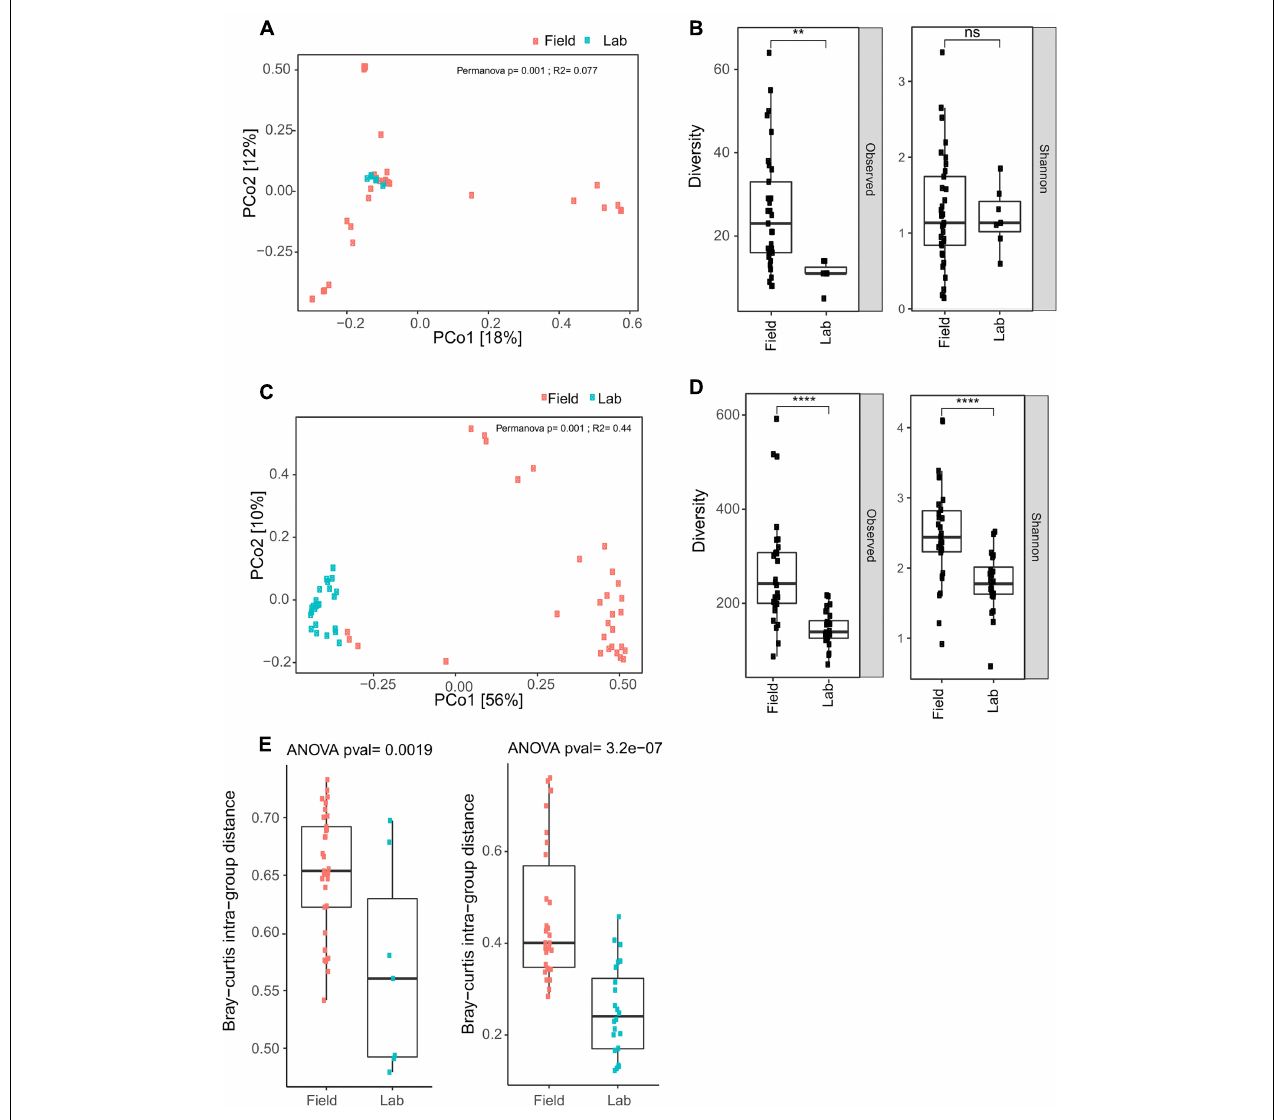
FIGURE 8 | Field collected samples display greater eukaryotic and prokaryotic microbial diversity than laboratory colony samples. (A) Bray Curtis Principal Coordinate Analysis (PCoA) for eukaryotic OTU data reveal clustering of field and laboratory colony samples. The cluster of eukaryotic microbes in the colony samples is nested within the distribution of data points for the field samples. (B) Observed diversity of eukaryotic taxa is significantly greater in field collected samples as compared to laboratory colony samples, but there is no significant difference in Shannon diversity (ns, non-significant; p > 0.05; **, p ≤ 0.01). Upper and lower bounds of the box indicate the third and first quartiles, respectively, and the line within the box indicates the median. Whiskers extends to the largest values no further than 1.5 time the inter-quartile range from the corresponding upper and lower bounds of the box. All individual data points are shown as individual dots. (C) Bray Curtis PCoA for prokaryotic microbiome data displays distinct clustering of field and laboratory samples. Inter-sample diversity is less among colony samples as compared to field collected samples, as indicated by the tighter clustering of individual data points for the colony samples. (D) Both observed and Shannon diversity measures are significantly greater in field collected samples as compared to laboratory colony samples (****, p ≤ 0.0001). (E) Bray-Curtis intra-group distance, a measure of within group diversity is significantly greater for field samples as compared to laboratory colony samples for the eukaryotic microbial diversity (left panel) and for the prokaryotic microbial diversity (right panel), indicating greater difference among field samples than larval samples collected from laboratory